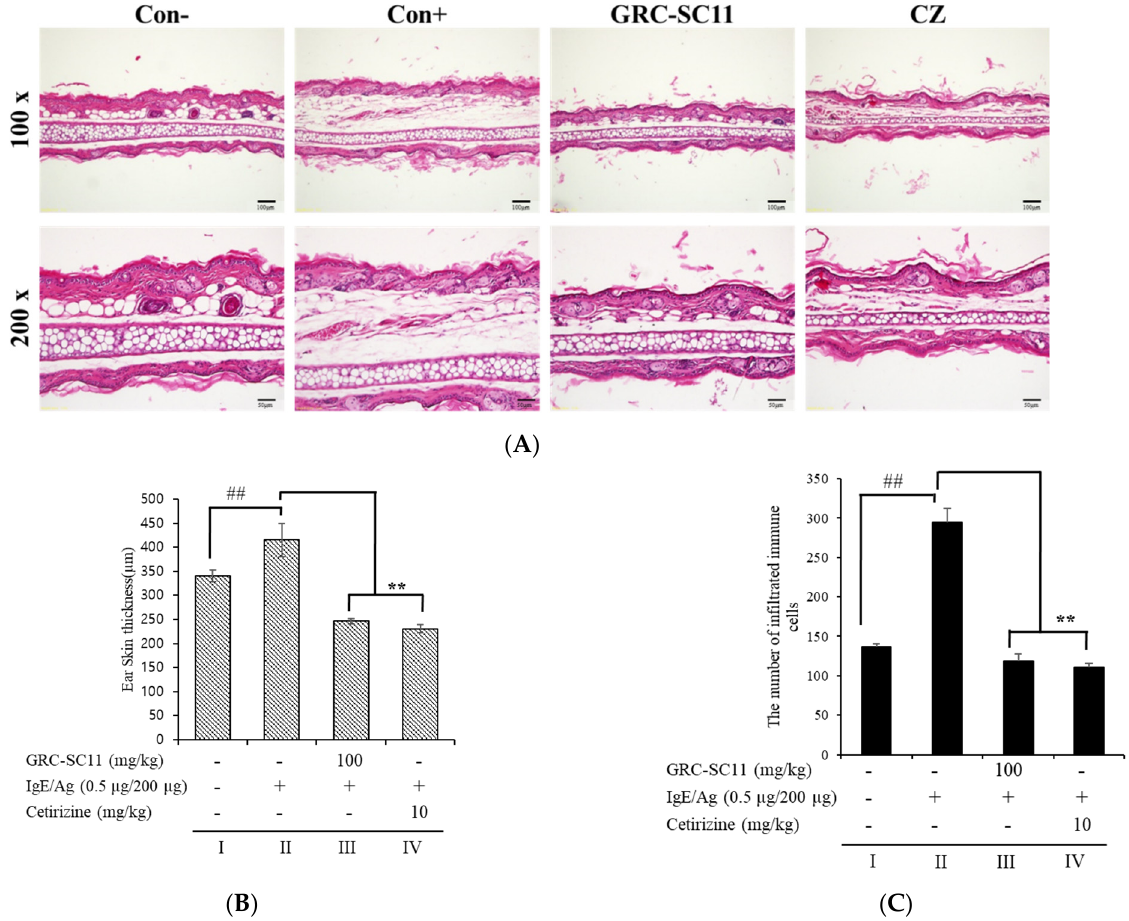
Figure 6. Effect of GRC-SC11 on IgE/Ag-induced ear swelling response in the BALB/c mice models. Histopathological examination of ear tissues of the IgE/Ag-triggered PCA BALB/c mice models. ( A ) Representative images of ear tissues stained with hematoxylin and eosin ( n = 7/group; magnifications, 100× and 200×) of group-I: normal control, group-II: PCA disease control (IgE/Ag, anti-DNP IgE sensitized and DNP-HAS challenged), group-III: GRC-SC11 (100 mg/kg), and group-IV: drug control (10 mg/Kg). ( B ) A dial thickness gauge was used to measure ear thickness. Data are expressed as mean ± SD ( n = 7/group). ( C ) Infiltrated immune cells were counted in the ear of mice. Data are expressed as mean ± SD ( n = 7/group). Results were considered significant at the level of ## p < 0.01 (compared with normal animals) and ** p < 0.01 (compared with normal PCA model control). Statistical analysis of results was performed through one-way ANOVA followed by Dunnett’s t -test.